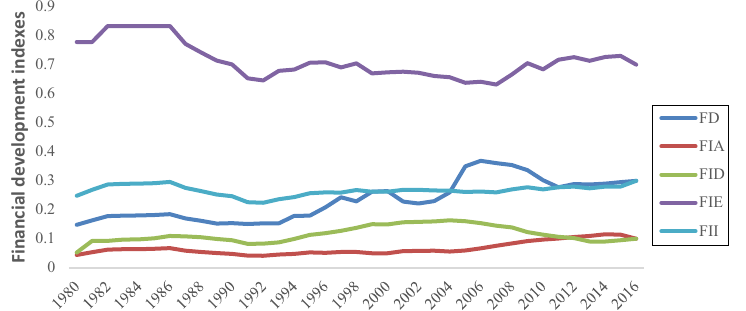
Figure 1. Financial